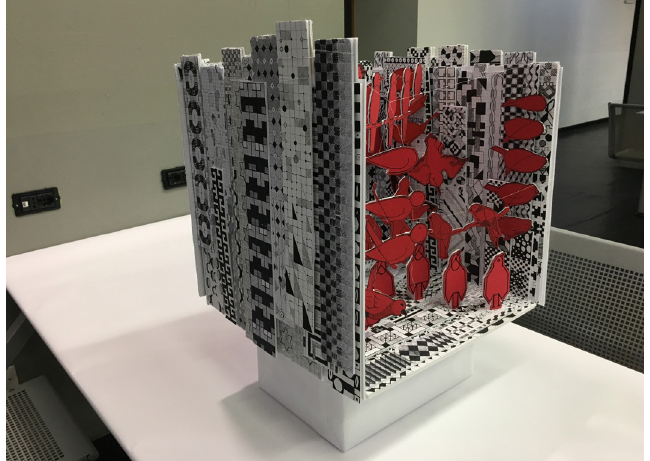
Fig. 5 Theater of the flying geometries work